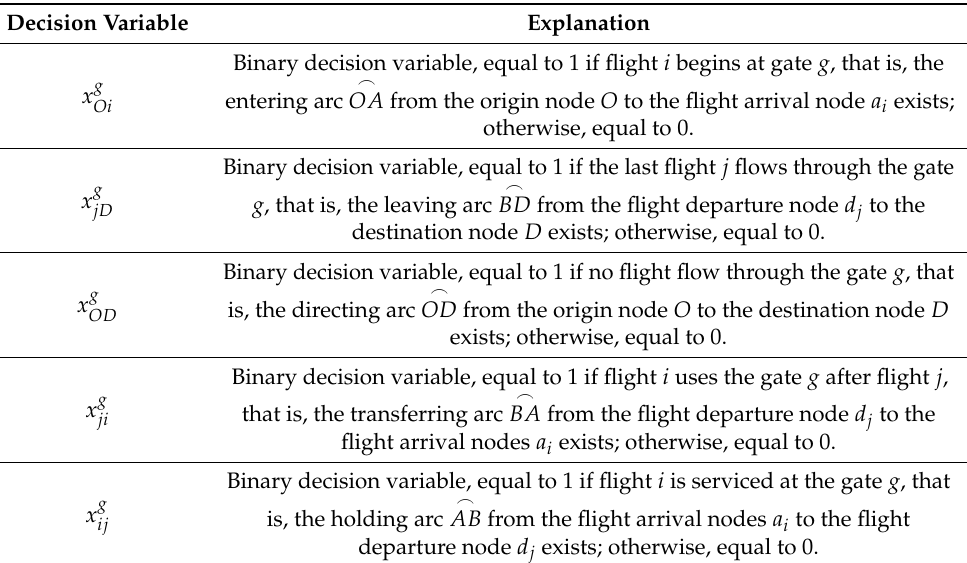
Figure 2. Basic diagram of the proposed multi-objective optimization problem. Table 1. Description of decision variables.